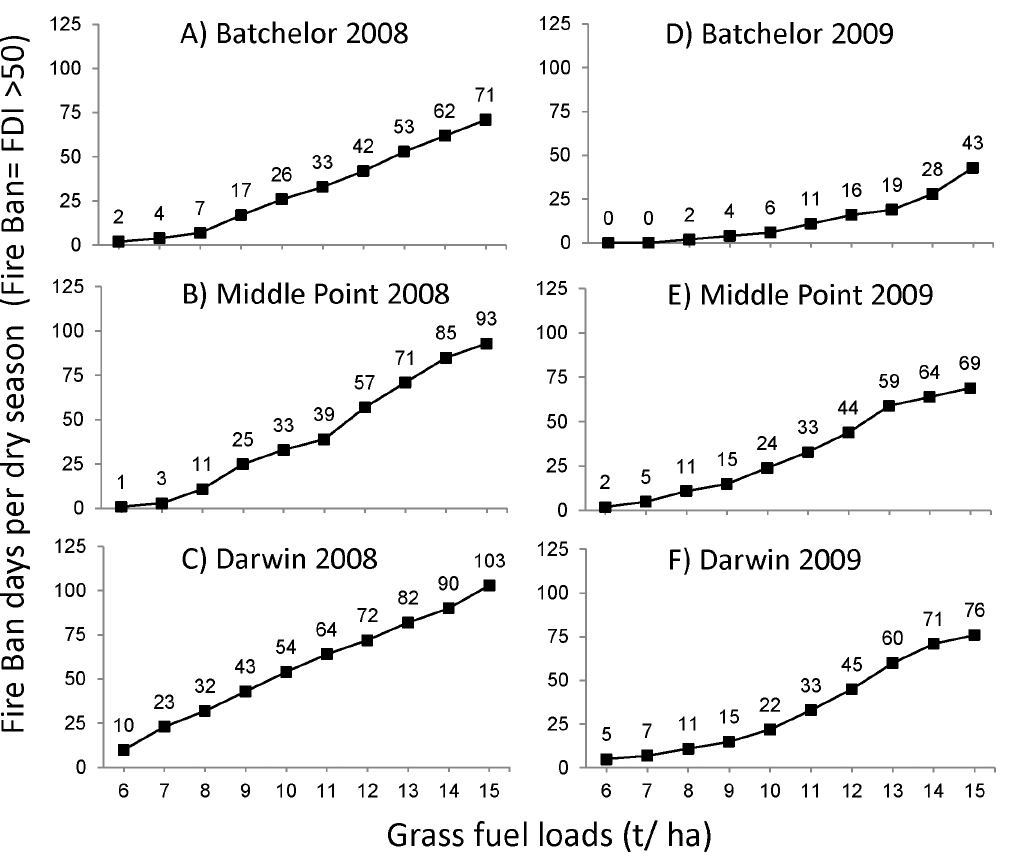
Figure 3. Number of days in the 2008 and 2009 fire season (1 st May to 31 st October) where the GFDI is $ 50, for the Batchelor, Middle Point and Darwin weather stations, NT, Australia. GFDI results are based on actual meteorological data from the three weather stations, fuel curing data and three different fuel load ( FUEL t ) scenarios (6, 10 and 15 t ha 2 1 ).